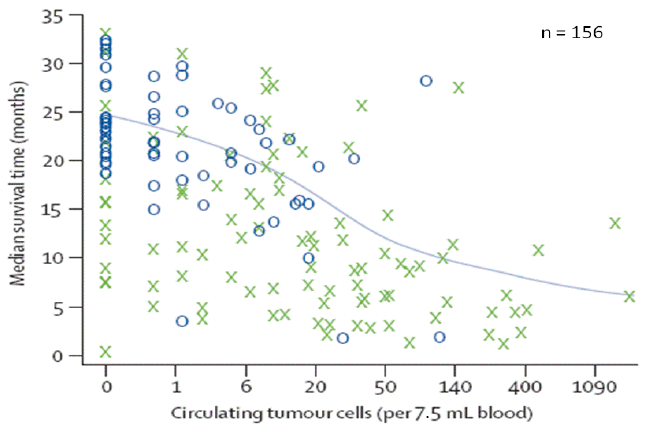
Figure 4. CTC count analyzed as continuous variable. Estimated median survival time according to baseline CTC count. Higher CTC count is associated with worse survival. X represents death; O represents lost to follow-up (reprinted from [45] with permission of